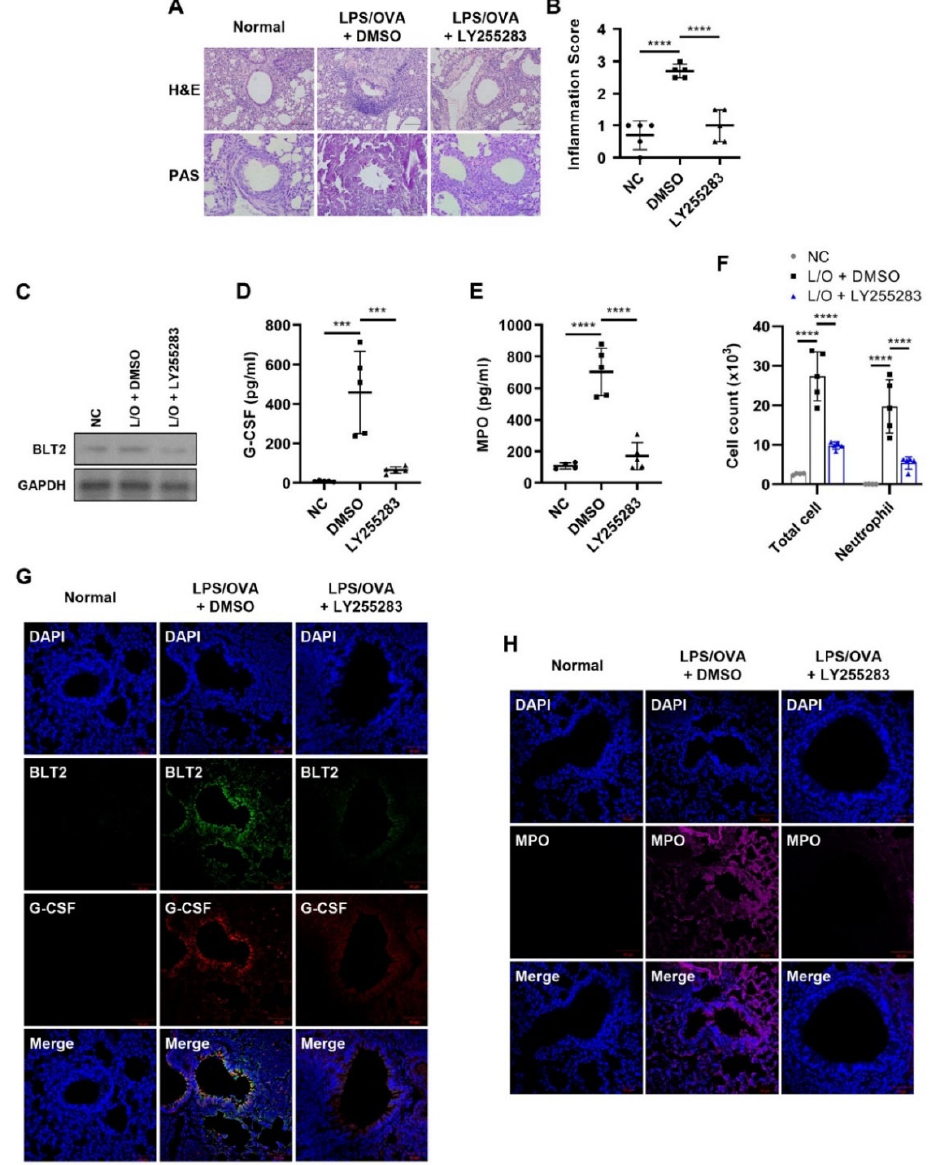
Figure 3. BLT2 mediates the production of G-CSF in neutrophilic airway inflammation. The BLT2 antagonist LY255283 (10 mg/kg) or DMSO was administered by i.p. injection 1 h before each challenge. The negative controls (NC) were untreated. ( A , B ) H&E and PAS staining of mice lung